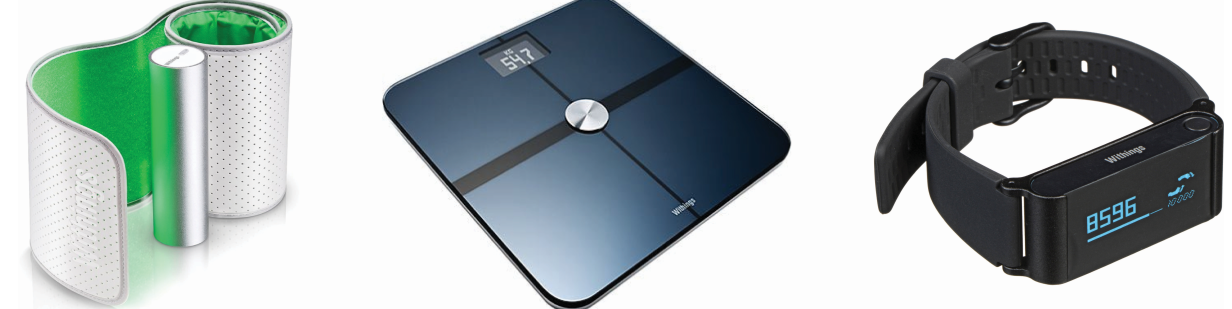
Figure 1. The equipment used in the remote monitoring group.